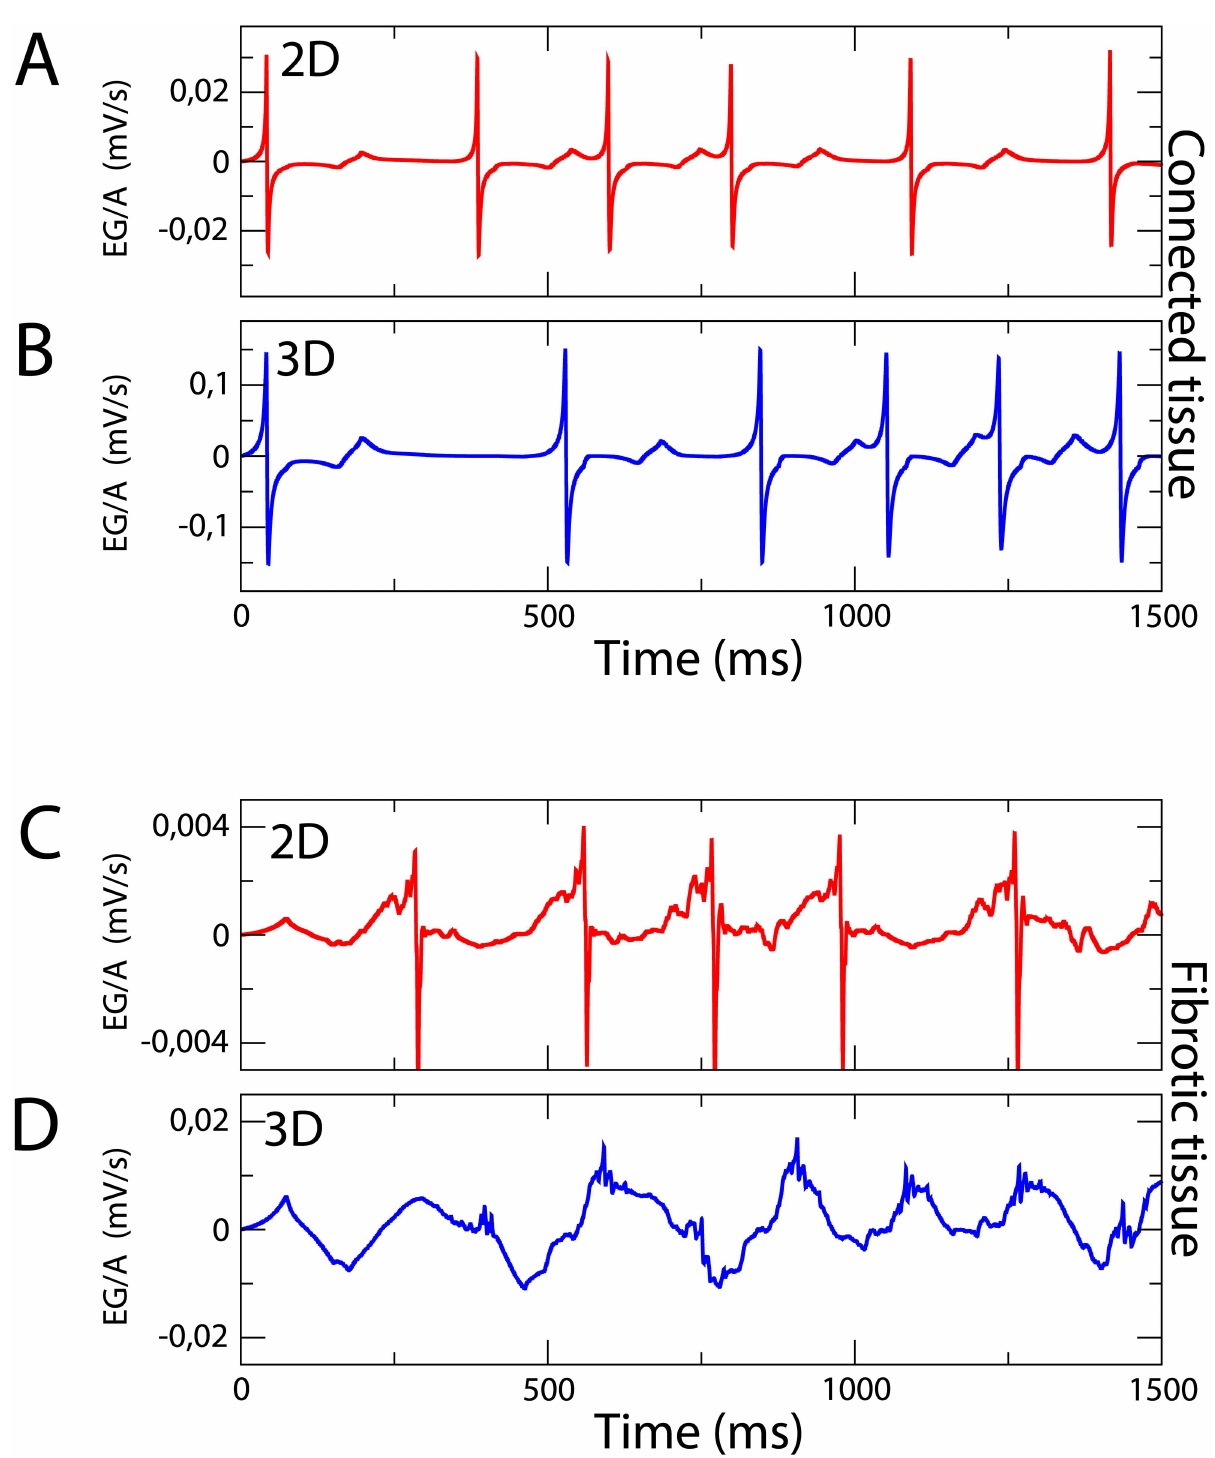
Fig 9. Comparison of Electrogramsin 2D and 3D. Electrogramscalculatedon two points correspondingto locations marked with (A) and (D) in Fig 8. Two-dimensional electrograms calculatedunder strong remodelingconditions outside(A) and inside(C) the fibrotic area ( ϕ = 0.48) in comparisonwith three-dimensional electrograms calculatedunder intermediate remodelingconditions outside (B) and inside (D) the fibrotic area ( ϕ = 0.72).